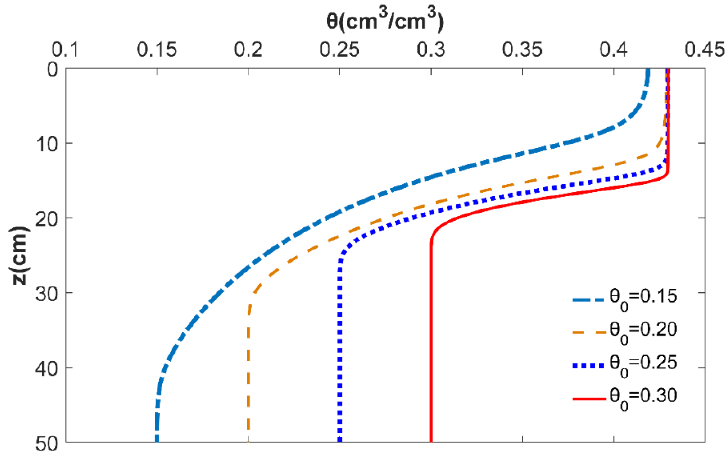
Figure 5. Profiles of soil water content at h 1 t with different initial soil water contents.